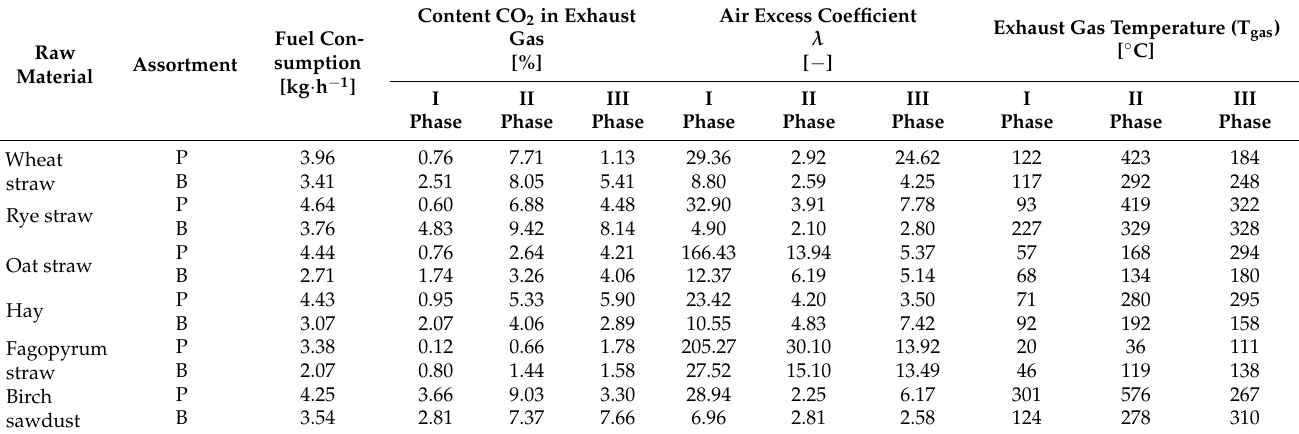
Table 2. Selected parameters describing the course of the combustion